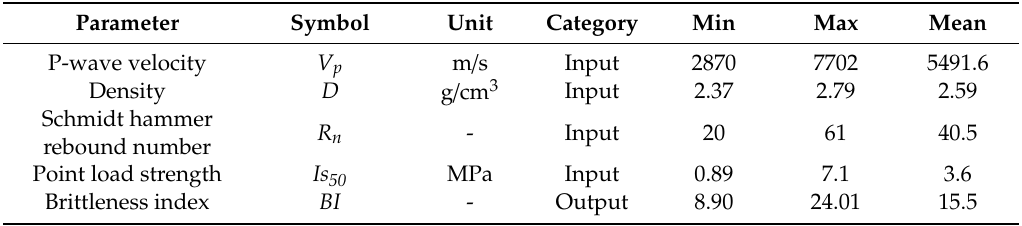
Table 1. The Range, Mean, Unit, Category and Symbol of Inputs and Output Parameters in Predicting BI of the Rock